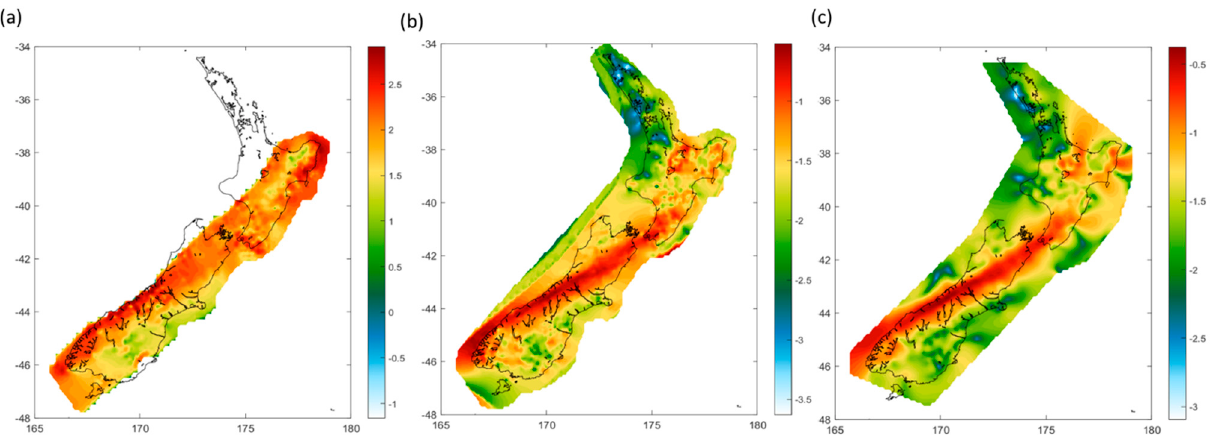
Figure 2. Spatial distribution of ( a ) GSS (1996–2013), ( b ) BSS (1996–2011), and ( c ) HWS (1995–2013) strain rate models in the New Zealand CSEP testing region. The colour scale shows the logarithm of the relative rate.